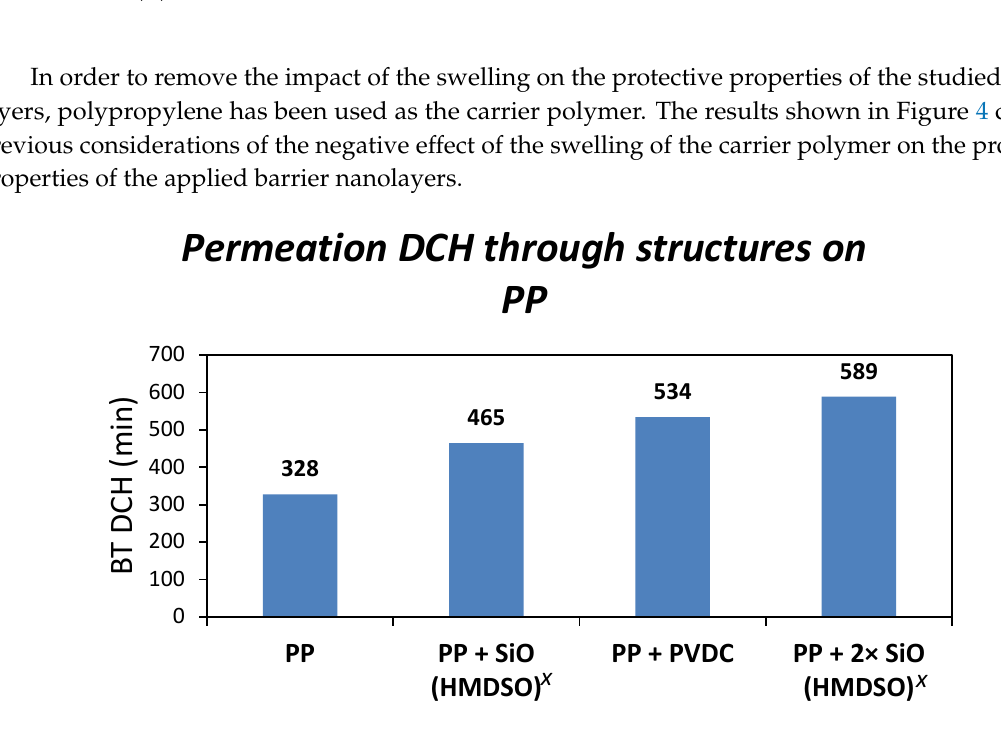
Figure 3. The resistance of the PEVA foil modified with different barrier layers against 1,6-dichlorohexane (DCH).